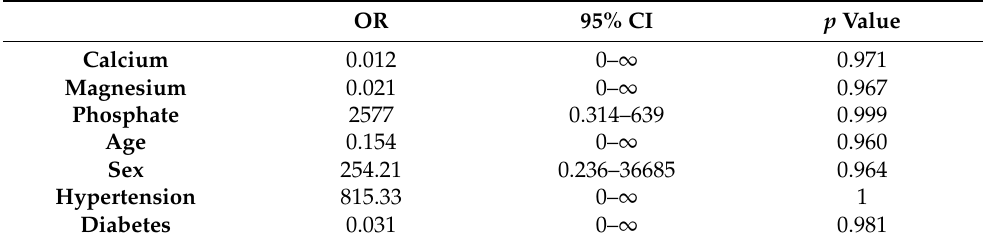
Table 2. Multivariate analysis of factors associated with vitamin D